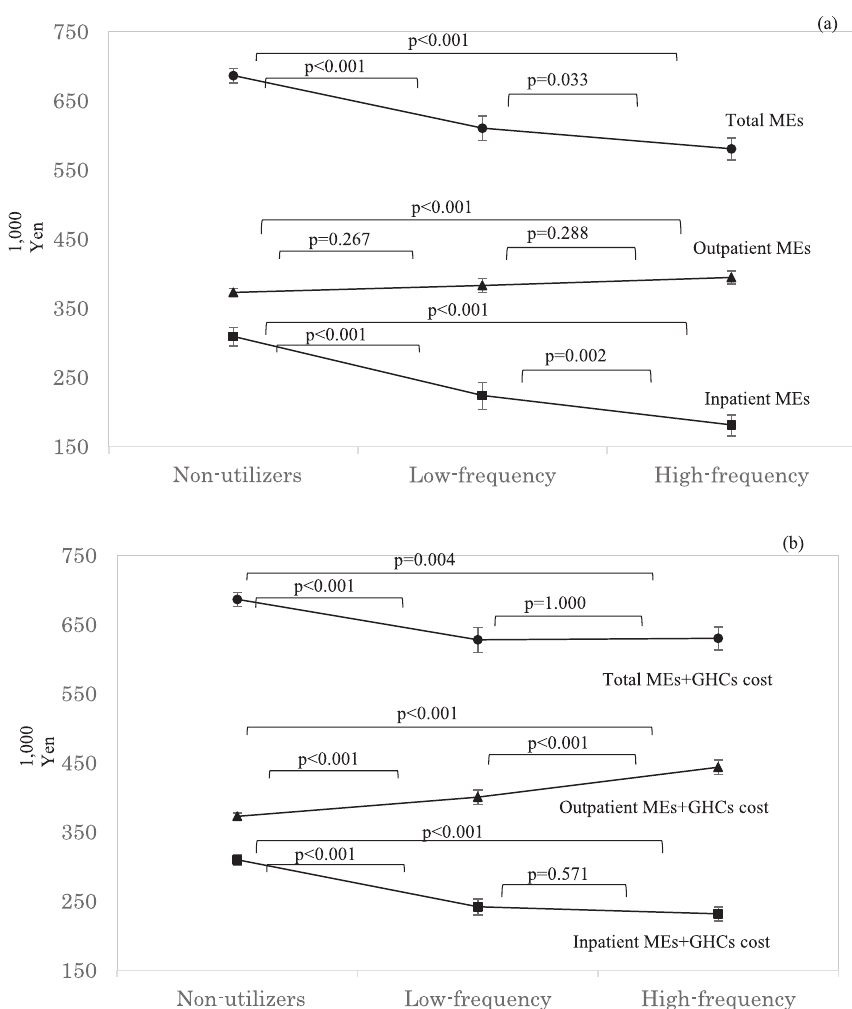
Fig.1. Medical expenditures (MEs) (a) and MEs plus general health checkup costs (b) of the pooled 2008 e 2010 data by subgroups of GHCs. The estimated marginal mean and 95% con fi dence interval for expenditure are expressed using Tweedie analysis in the generalized linear models (GLM) adjusted for age and sex. p -values show the three pairwise comparisons among utilization groups, with Bonferroni's post-hoc test in the GLM. The cost unit is expressed as a thousand yen, with the exchange rate of 1000 yen ¼ 8.3 dollars or 7.5 euro. GHC, general health